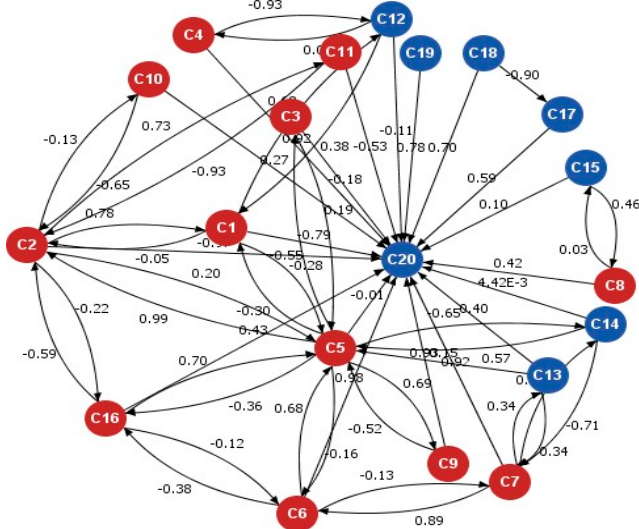
Figure 3. A fuzzy cognitive map demonstrating the notional causal relationships. Twelve nodes (red) are decision drivers, feeding into C20, the startle concept.